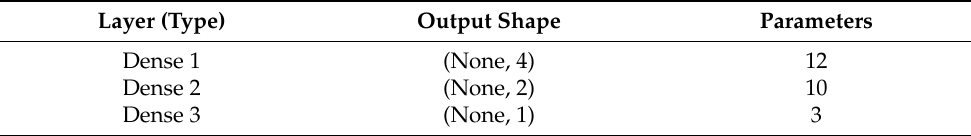
Table 4. The higher-order neural network model